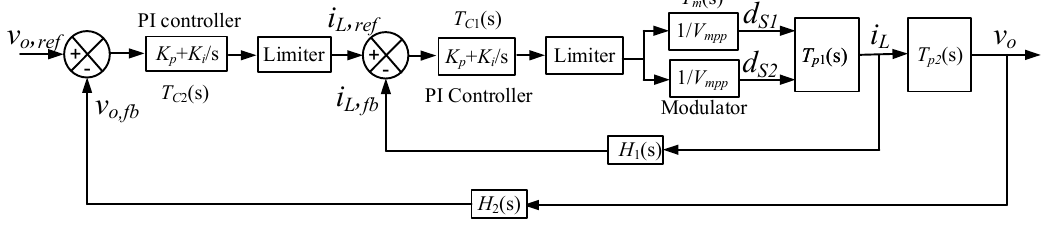
Figure 4. Complete two-loop average current control block diagram.